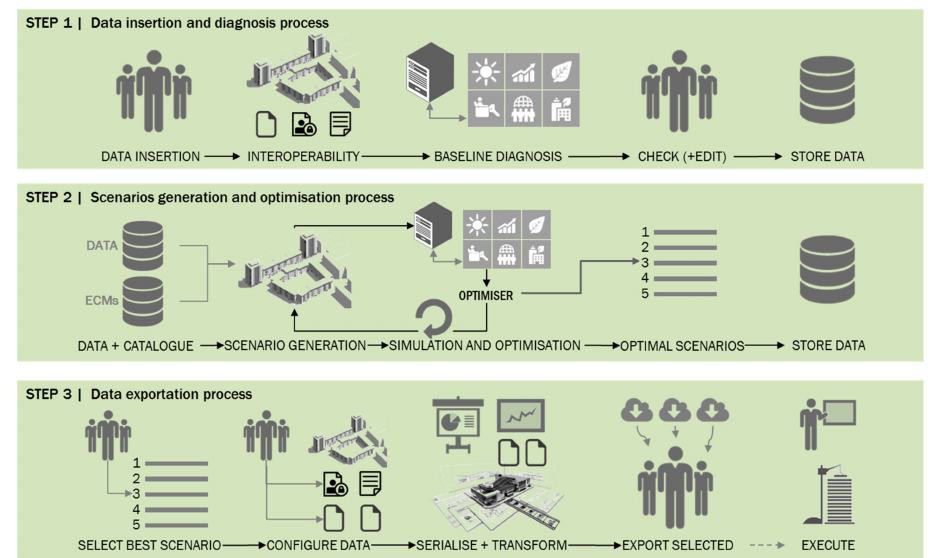
Figure 1. Steps enabling the deployment of OptEEmAL methodology. ECM—energy conservation